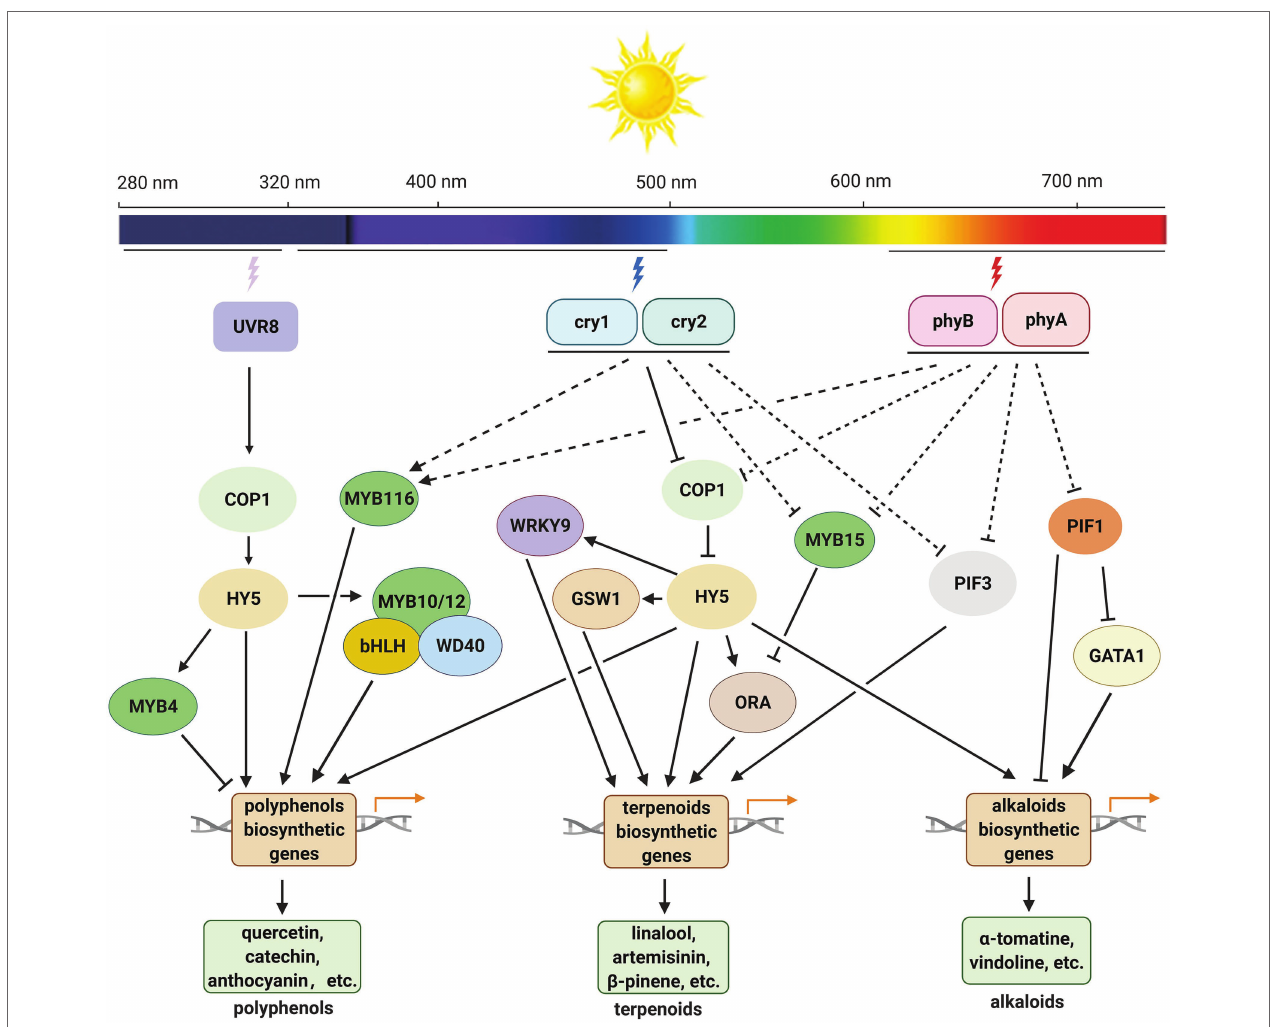
FIGURE 4 | Working model for light-mediated biosynthesis of polyphenols, terpenoids, and alkaloids in medicinal plants. Upon UV-B radiation, the UVR8 homodimer undergoes monomerization and interacts with COP1, which increases COP1 stability and induces HY5 expression. HY5 regulates the expression of genes encoding transcription factors and/or key enzymes involved in the biosynthesis of SMs and affects the accumulation of SMs under UV-B. Under blue and red light, cryptochromes (cry1 and cry 2) and phytochromes (phyA and phyB) inhibit the E3 ligase activity of COP1, HY5 accumulates in nucleus and promotes the expression of transcription factor and/or key enzyme genes in the related biosynthetic pathways of SMs. Phytochromes may also affect the accumulation of alkaloids by mediating the function of PIF1 and PIF3 in some species. COP1, CONSTITUTIVELY PHOTOMORPHOGENIC1; cry1 and cry2, cryptochrome 1 and cryptochrome 2; GATA1, GATA-type transcription factor 1; GSW1, GLANDULAR TRICHOME-SPECIFIC WRKY 1; HY5, LONG HYPOCOTYL 5; ORA, AP2/ERF type transcription factor; phyA and phyB, phytochrome A and phytochrome B; PIF1, phytochrome interacting factor 1; PIF3, phytochrome interacting factor 3; UVR8, UV RESISTANCE LOCUS